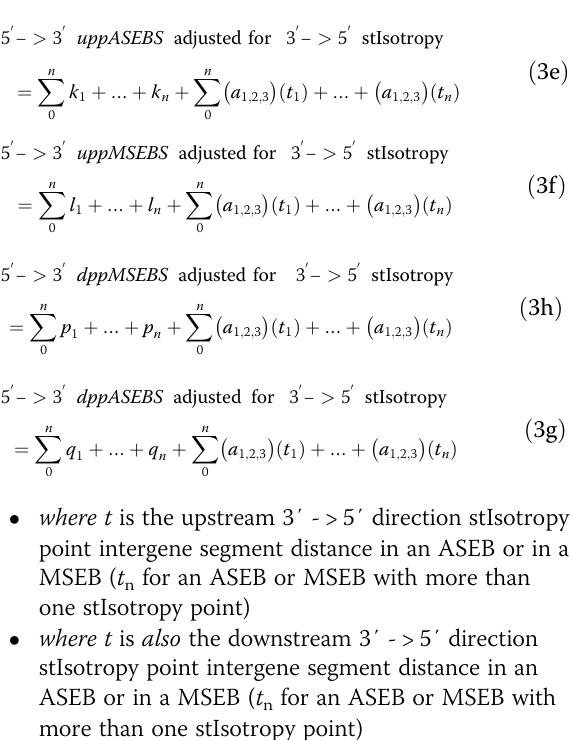
The 5 ′ - > 3 ’ uppASEBS adjusted for uppASEBS 3 ′ - > 5 ′ stabilizing isotropy (stIsotropy) ( Eq. 3e ), 5 ′ - > 3 ’ uppMSEBS adjusted for uppMSEBS 3 ′ - > 5 ’ stIsotropy